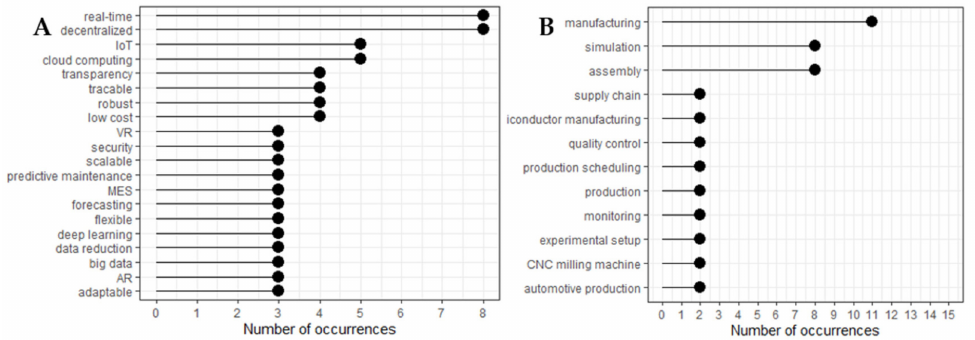
Figure 6. ( A ): Most commonly occurring features in papers. ( B ): Most frequent application domains in papers.